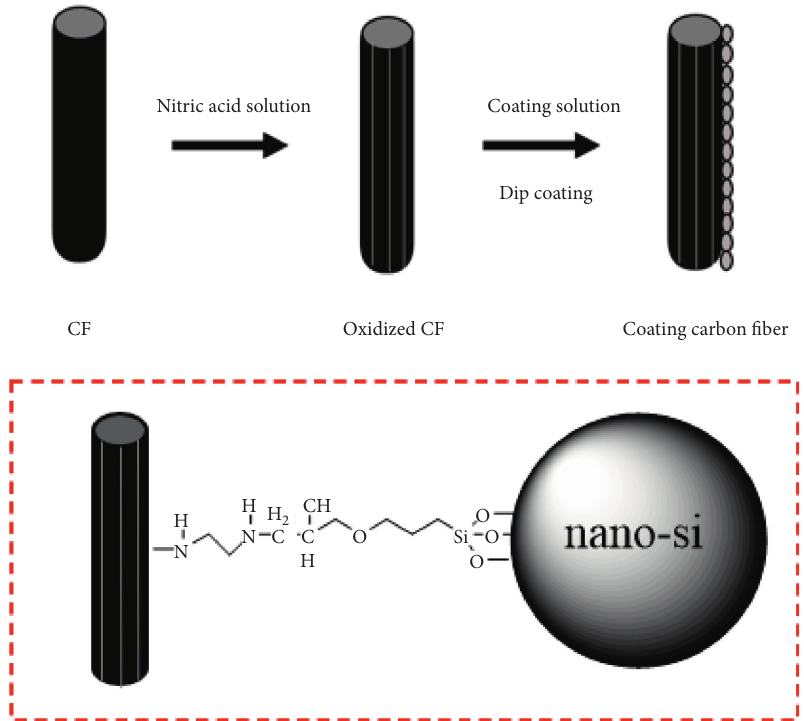
Figure 2: Surface modification process of the carbon